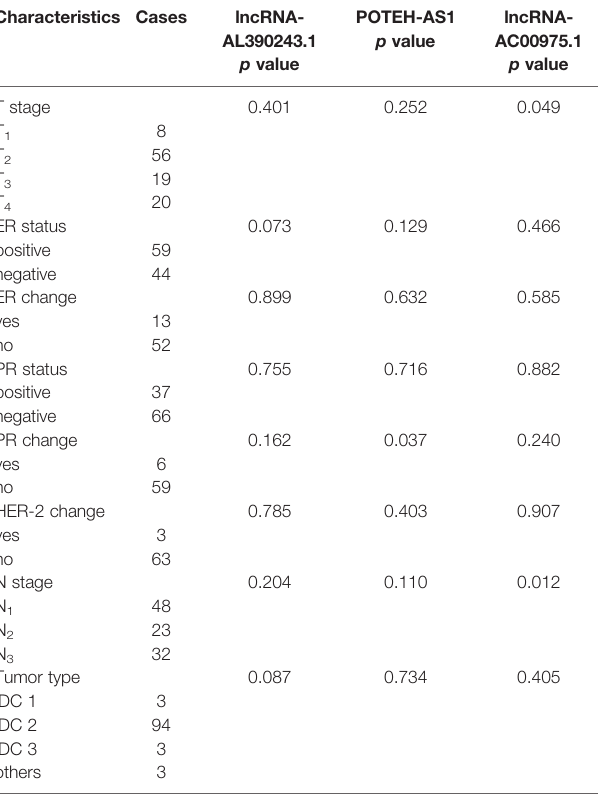
TABLE 3 | The relationship between lncRNA expression level and clinical characteristics. Characteristics Cases